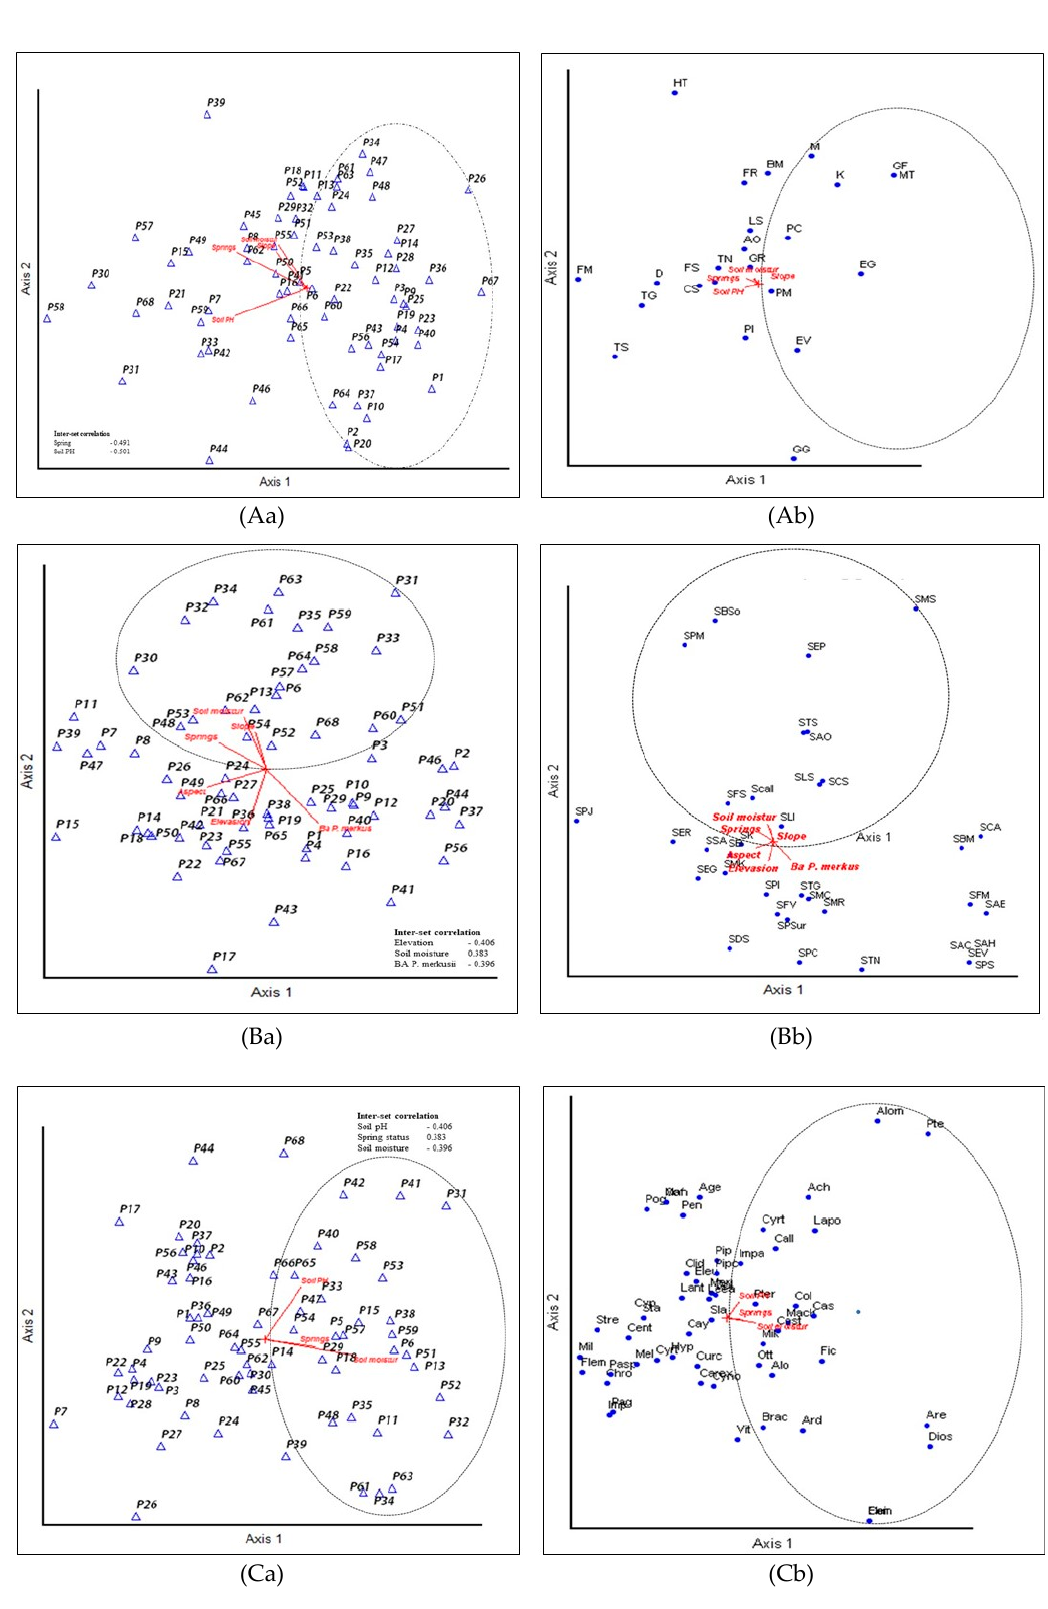
Figure 3. Canonical correspondence analysis (CCA) ordination for species and their environmental features. ( Aa = plot ordination at tree/pole level, Ab = species ordination at tree/pole level, Ba = plot ordination at sapling level, Bb = species ordination at sapling level Ca = plot ordination at seedling/herbs level, Cb = species ordination at seedling/herbs level). Note: P1 – P29 were explored in Watujali, P30 – 69 were in Silengkong. ( A ) PM = Pinus merkusii , CS = Cassia siamea , AO = Arenga obtusifolia , FS = Ficus septica , TG = Tectona grandis , PC = Peronema canescens , LS = Laportea sinuate , HT = Hibiscus tiliaceus , GR = Gluta renghas , K = Knema s p., GF = Ganophylum falcatum , MT = Macaranga tanarius , FM = Ficus microcarpa , TS = Tabernaemontana sphaerocarpa , EG = E. glaber , FR = Flacortia rukem , D = Dyospiros sp., BM = Bridelia monoica , M = Macaranga sp., EV = Erytrina variegate , TN = Tetramela nudiflora , PI = Pterocarpus indicus. ( B ) SEV = Erytrina variegate . SAH = Artocarpus heterophylus , SAC = Artocarpus camani , SPS = Parkia speciose , SPI = Pterocarpus indicus , SCS = Cassia siamea , SPM = Pinus merkusii , STG = Tectona grandis , SLS = Laportea sinuata , SFS = Ficus septica , SLI = Leea indica , SER = Erioglossum rubignosum , SMR = Macaranga sp., SK = Knema sp . , SEP = Eugeunea polyanta , SPC = Peronema canescens . SAE = Ardicia eliptica , SFM = Ficus microcarpa , SSA = Streblus asper , SPSur = Piper canimum , SBM = Bridelia monoica , STS = TTabernaemontana sphaerocarpa , SMR = Macaranga rhizonoides , SBSo = Baringtonia macrophyla , SAO = Arenga obtusifolia , Scall = Calliandra sp., SDS = Dyospiros sp., SPJ = Pterospermum javanicum , STN = Tetramela nudiflora , SEG = Elaeocarpus glaber . (C) MacK = Macaranga sp., Clid = Clidemia hirata , Hyp = Hyptis capitata , Sta = Stachtarpheta indica , Alo = Alocasia culculata , Col = Colocasia gigantea , Mik = Mikania micranta , Cay = Cayyratia sp., Cyrt = Cyrtococum trigonum , Opl = Oplisemenus compositus , Ott = Ottochloa nodosa , Cyrt = Cyrtococum sp., Carex = Carex bacans , Pip = Piper samentosum , Pag = Pagostemon sp., Lant = Lantana camara , Age = Ageratum conyzoides , Chro = Chromolaena odorata , Pasp = Paspalum conjugatum , Eleu = Eleusine indica , Impa = Impatiens balsamania , Cost = Coctus spicatus , Curc = Curculigo orchioides , Dios = Dioscorea hyspida , Sla = Selaginella sp., Vit = Vitex laevifolium , Ach = Achasma sp.,